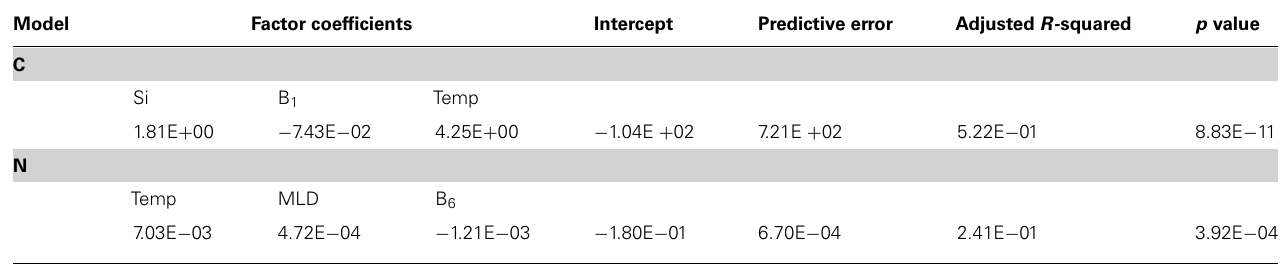
Table 3 | Multiple linear regression model factor coefficients and statistical results for carbon fixation in the less than 10- μ m size class and nitrogen fixation in the greater than 10- μ m size class.